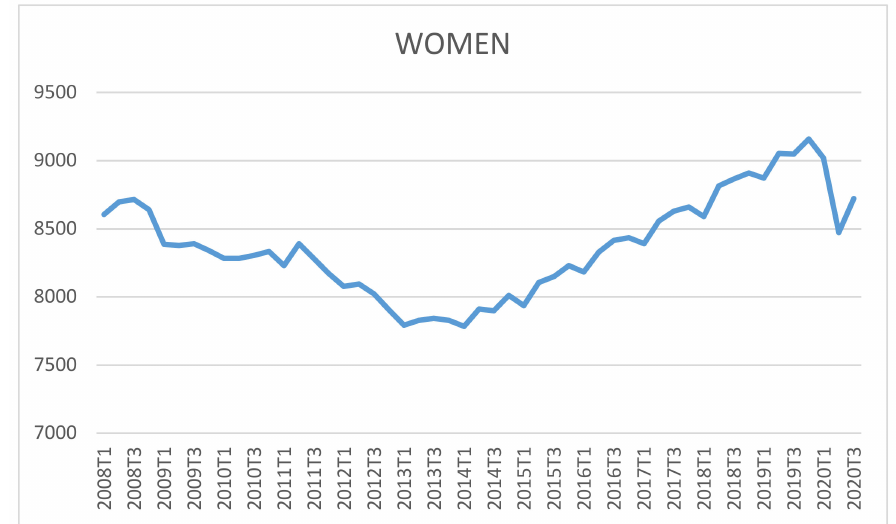
Figure 6. Evolution of female labor market. Source: Own elaboration from data of the Spanish National Statistics Institute (INE) [36].